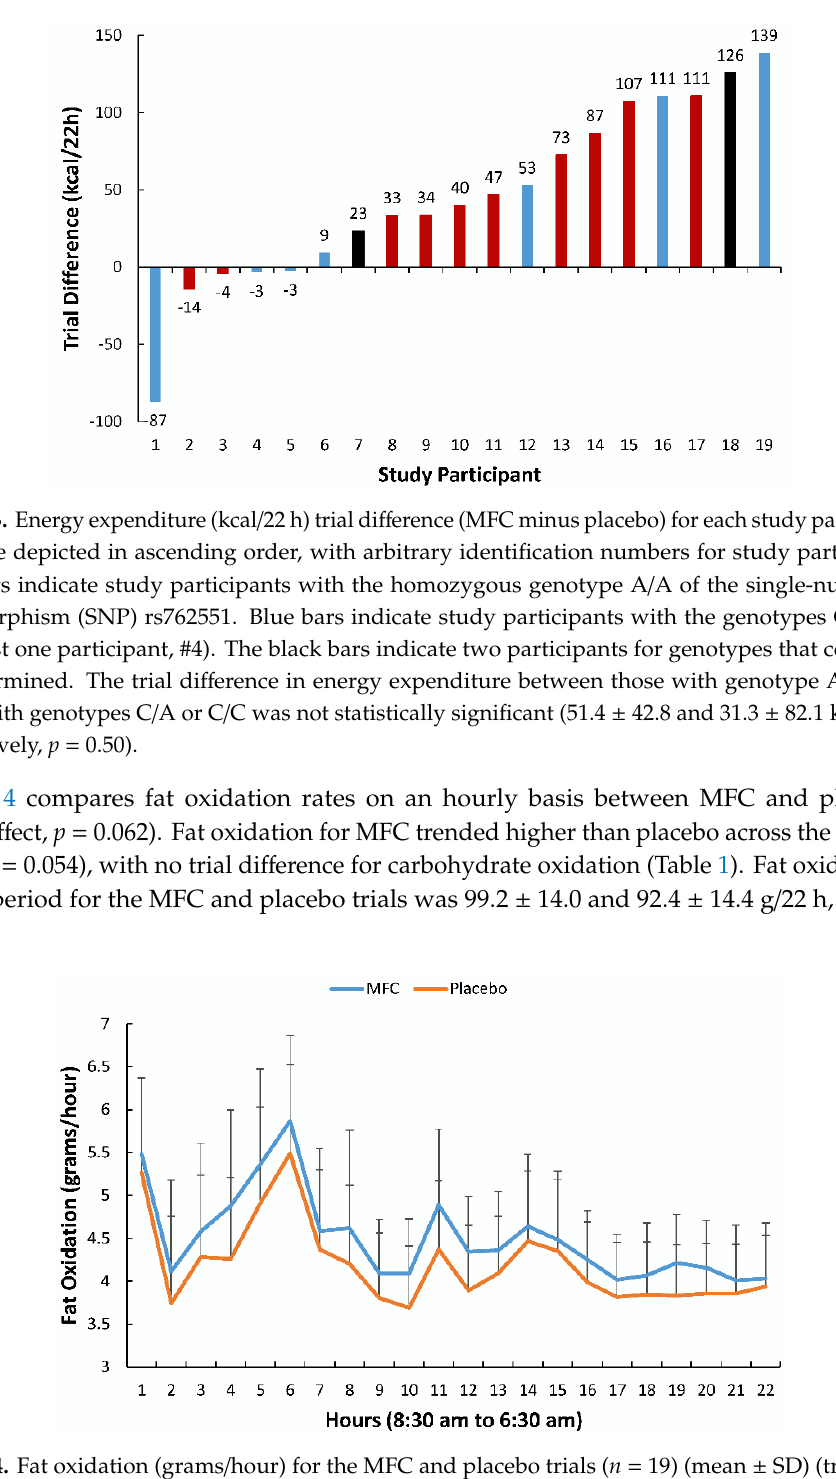
Figure 4. Fat oxidation (grams/hour) for the MFC and placebo trials ( n = 19) (mean ± SD) (treatment effect, p = 0.062). Supplements were ingested at 8:30 (hour 1) and 13:00 (hour 5). Breakfast, lunch, and dinner were served at 9:00 (hour 1), 13:30 (hour 5), and 18:30 (hour 10), respectively. Lights were turned off for sleep at 22:30 (hour 14).